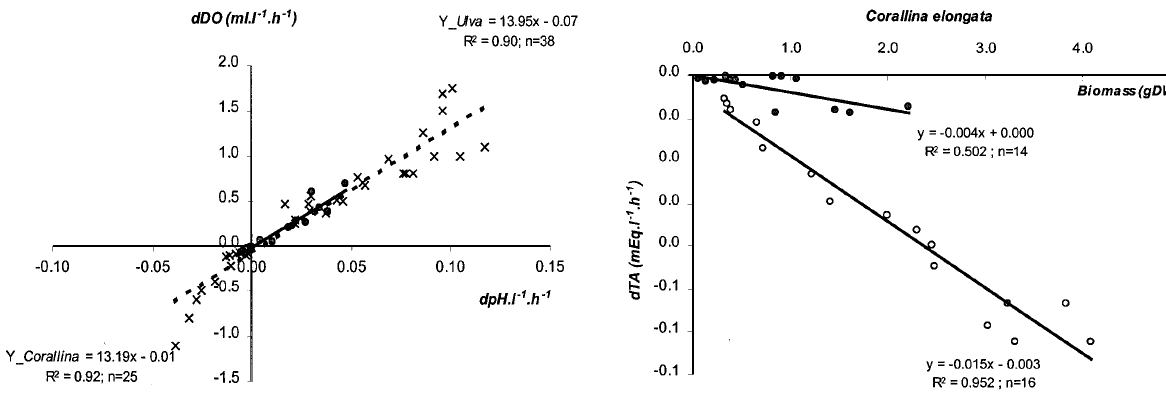
F IG . 3. – Regression plot between pH and DO variations of C. elongata (dots) and U. rigida (cross).